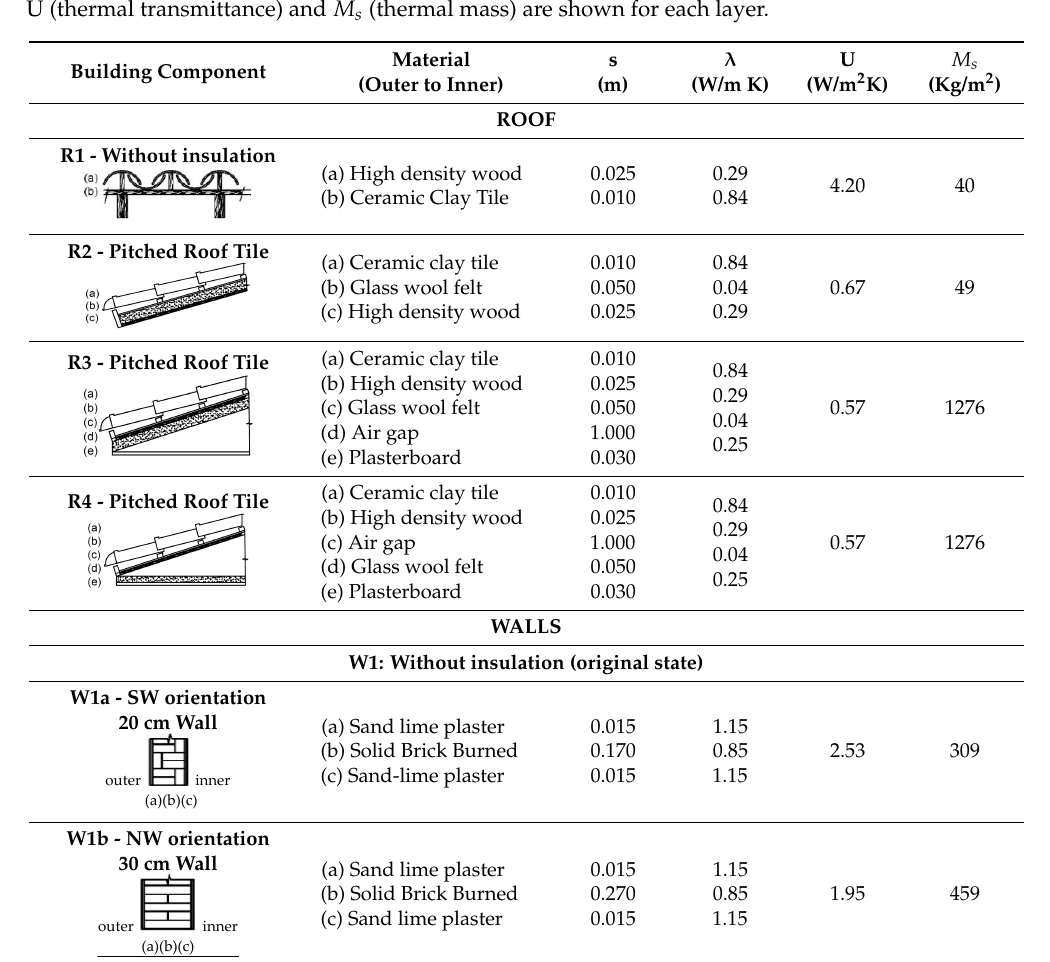
Table 4. Building’s envelope components description. The values of s (thickness), λ (thermal conductivity), U (thermal transmittance) and M s (thermal mass) are shown for each layer.